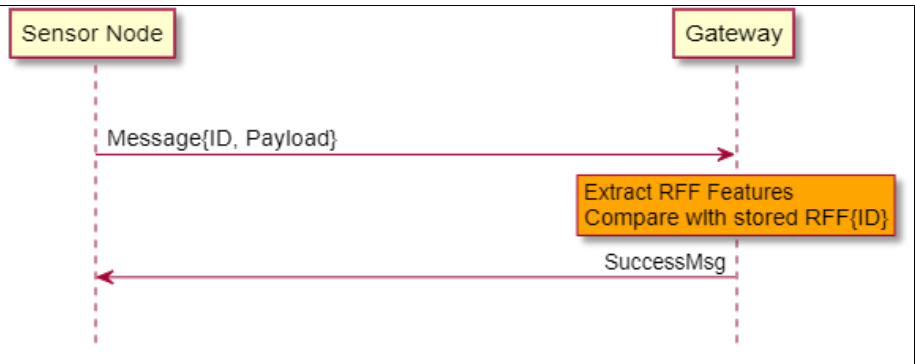
Figure 3. Successful authentication by RFF.